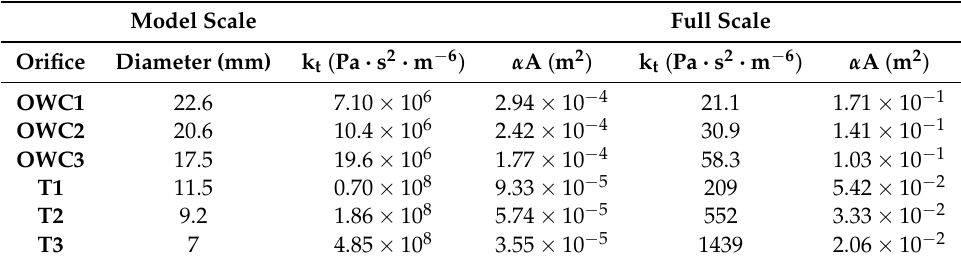
Table 2. Orifice characteristics for the conventional OWC and Tupperwave